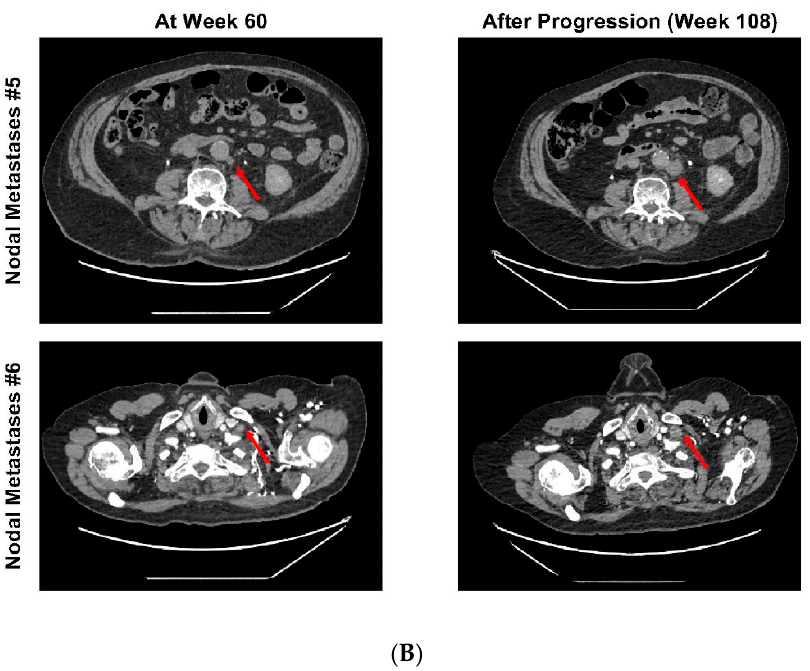
Figure 2. ( A ) Initial tumor scans (at start of rucaparib treatment) compared with scans at the time of best response (week 60 of rucaparib treatment) of nodal metastases and lytic bone metastases at the target lesions. ( B ) Scans at the time of best response (week 60 of rucaparib treatment) compared with scans after radiographic progression.